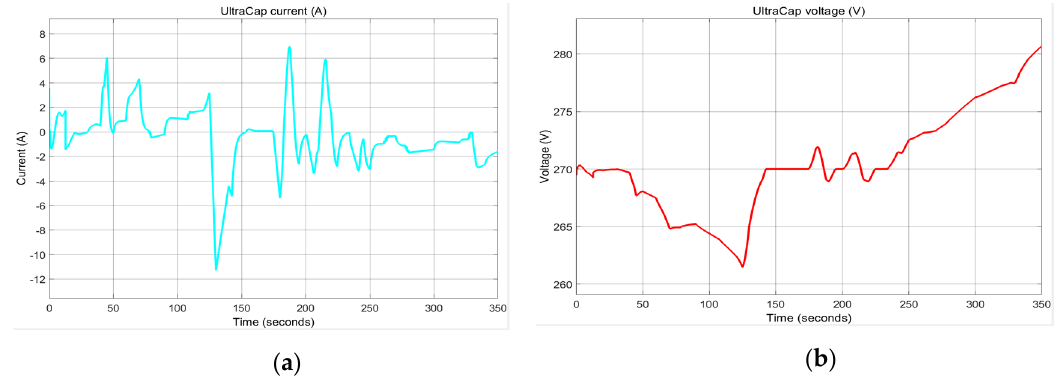
Batteries 2020 , 6 , x FOR PEER REVIEW Figure A5. SC specific variables. ( a ) SC current variation; ( b ) SC voltage.